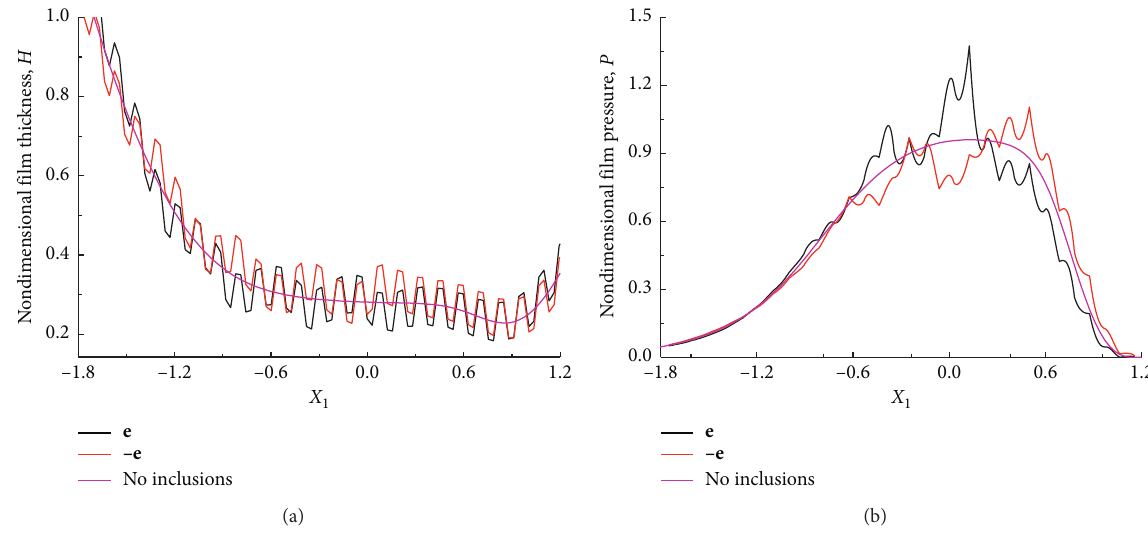
Figure 8: Nondimensional film thickness and pressure of the square roughness with eigenstrains, e and − e .